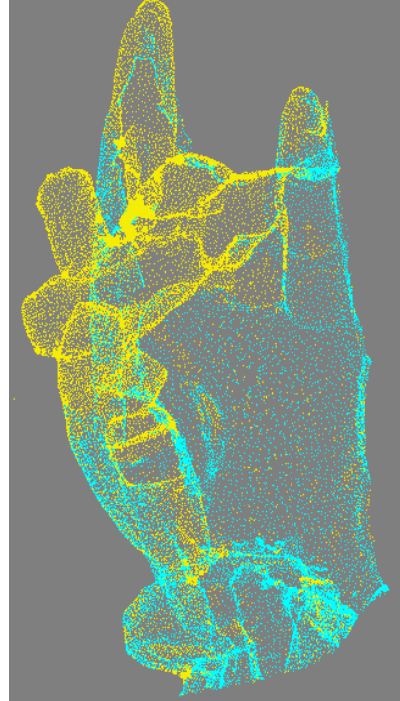
Figure 22. A contrasted view of point cloud data before and after the virtual restoration.